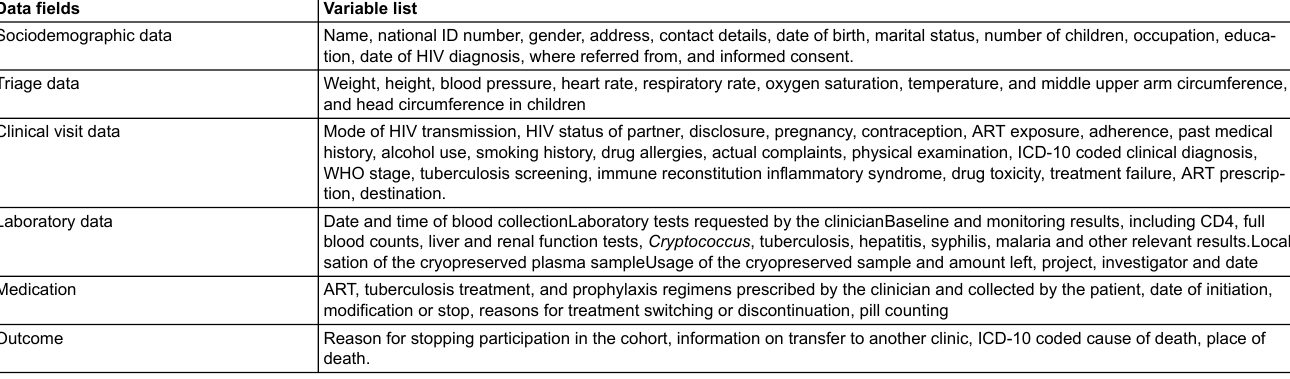
Table 2: Summary of the variables collected in